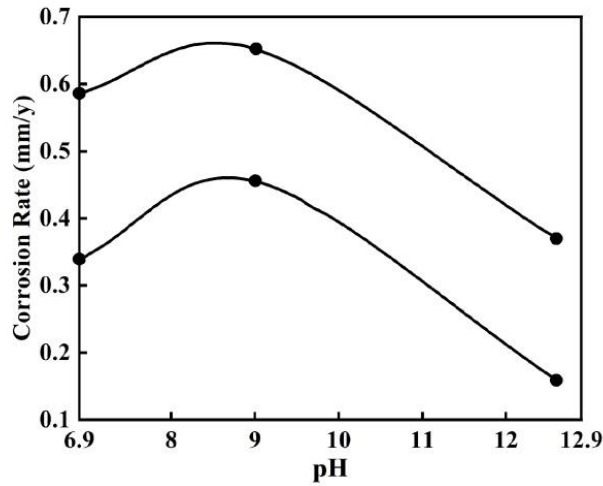
Figure 9. Corrosion rates of IS and NS rebars in different pH solutions [78]. Reproduced with permission of National Association of Corrosion Engineers, copyright 2022. Table 2. The role of second phase particles in inducing corrosion of rebars.